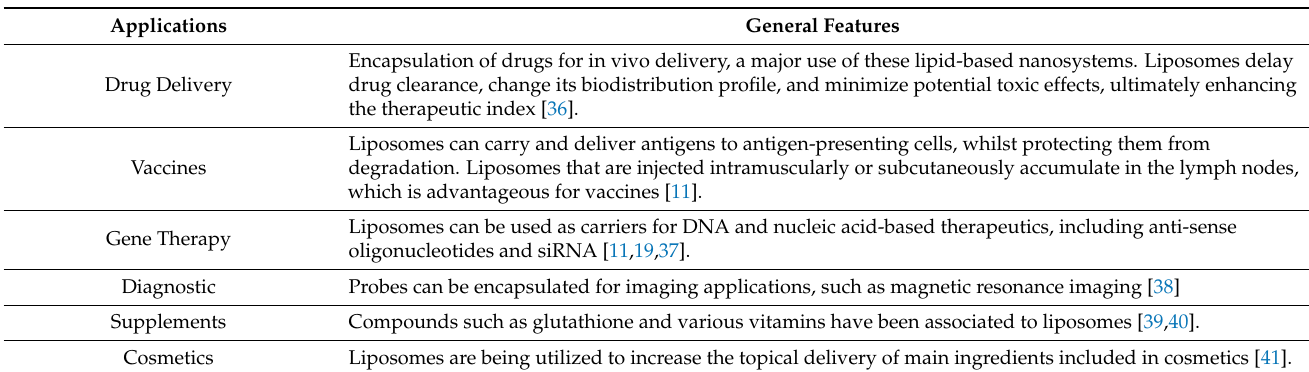
Table 2. Description of some applications of liposomes